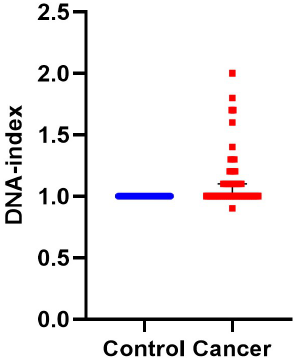
Figure 2. DNA-index represents aneuploidy of tumor cells. DNA-index values have been quantified by iFC and plotted, representing normal (blue dots) and cancer (red dots) cells in individual patient samples, respectively. While normal cells (taken from normal bladder tissue) are diploid, a DNA-index of ≠1 is a common, unique hallmark of cancer cells. The Median DNA index is depictred as a black horizontal line in each group.